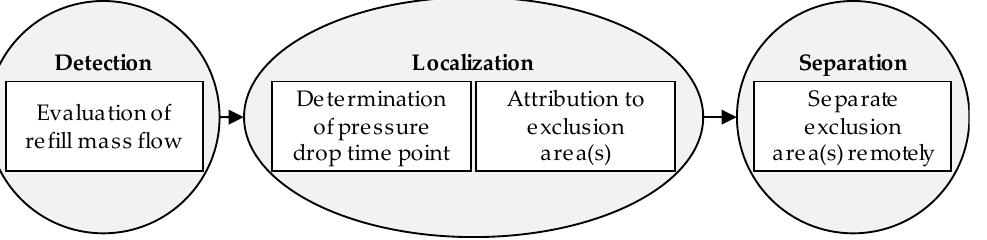
Figure 2. Emergency management steps in the case of a large spontaneous leakage with imminent shutdown of the network (Reprinted with permission from Ref. [3]. 2022, Vahldiek).